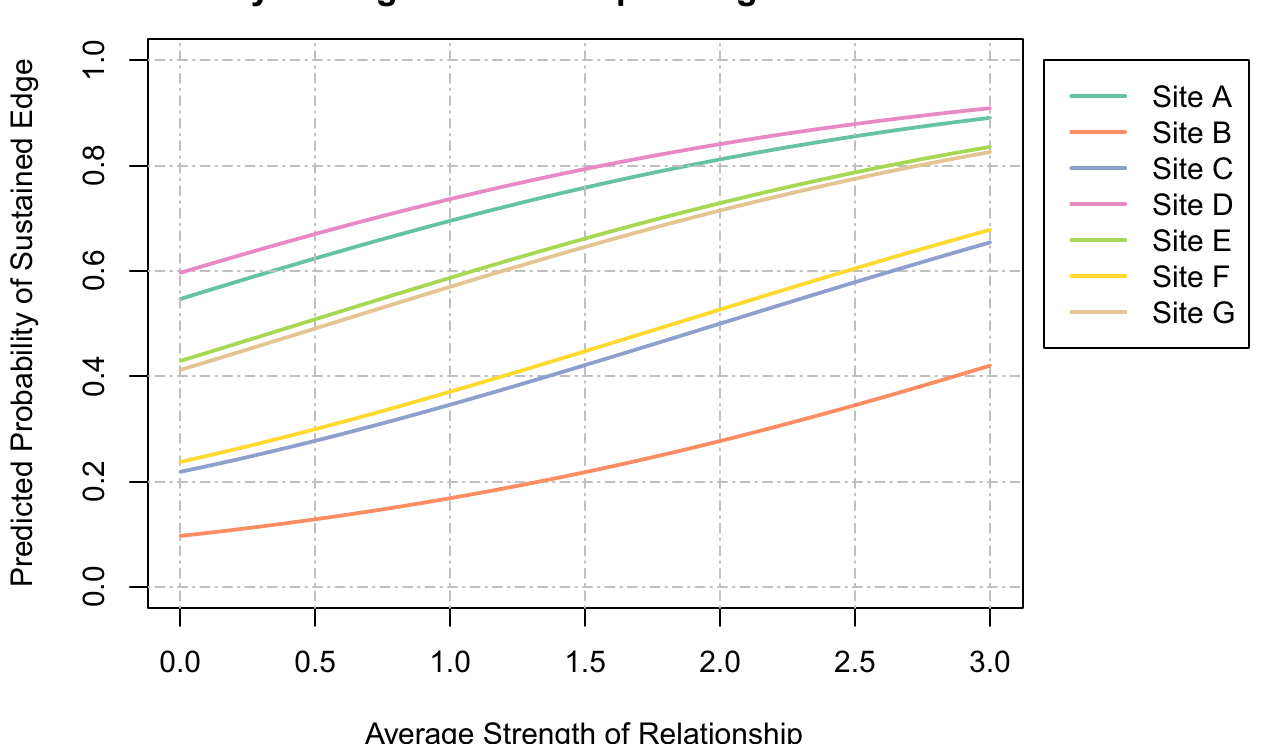
Fig 2. Iowa ACH site-level relationships between predicted probability of edge sustainment and average self-rated strength of relationship.